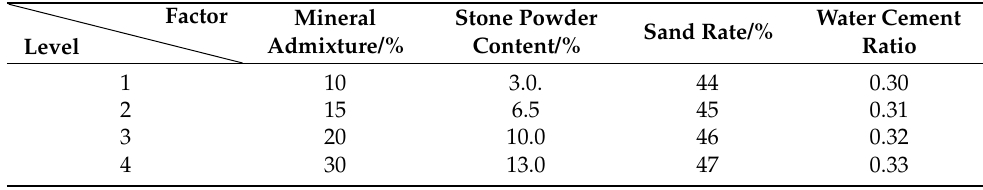
Table 2. L 16 (4 4 ) orthogonal experimental design table.